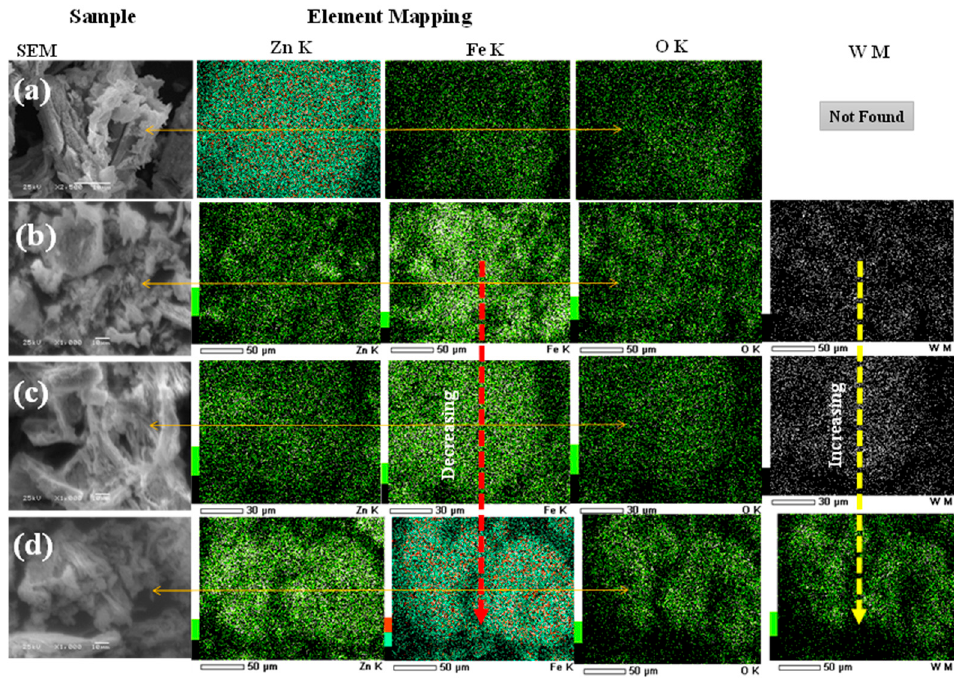
Figure 3. EDS mapping micrographs of ( a ) ZnFe 2 O 4 , ( b ) ZnW 0.05 Fe 1.95 O 4 , ( c ) ZnW 0.1 Fe 1.90 O 4 , and ( d ) ZnW 0.15 Fe 1.85 O 4 .